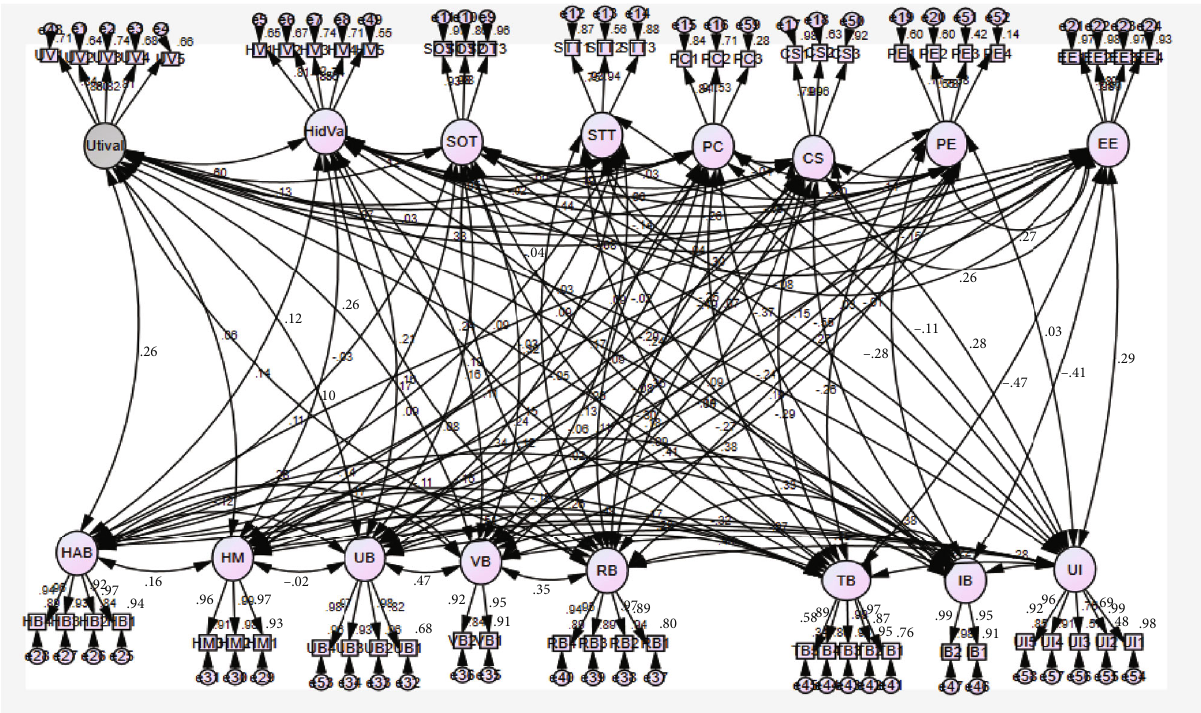
Figure 2: Initial CFA.